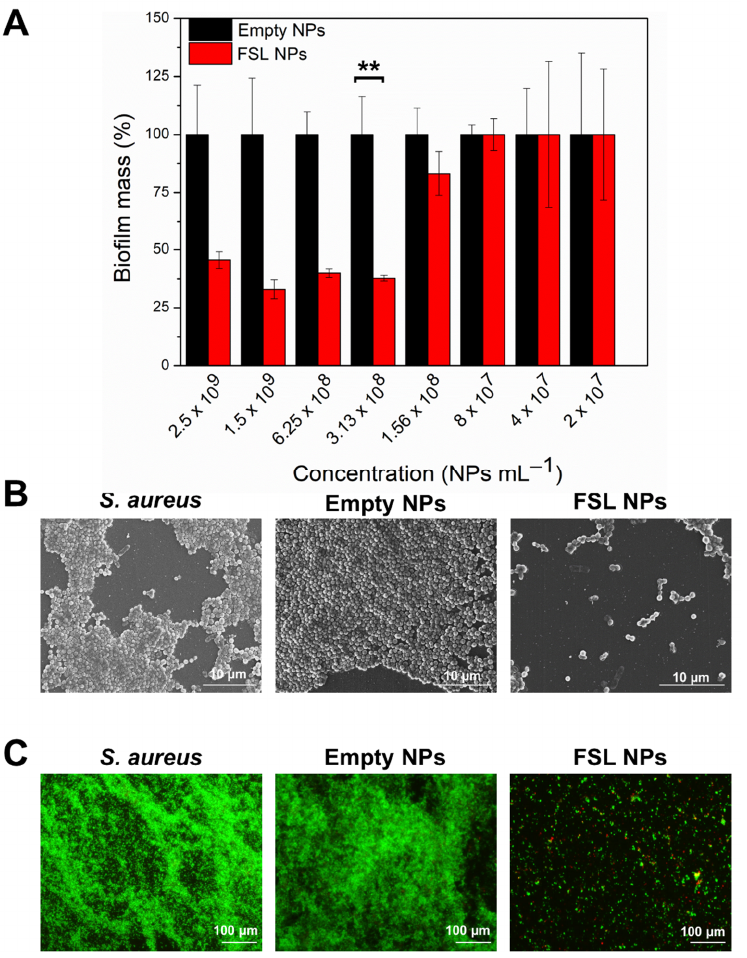
Figure 5. Elimination of S. aureus biofilm grown for 24 h. ( A ) Total biofilm quantification using crystal violet assay after treatment with increasing concentration of empty and FSL NPs. ( B ) SEM images of biofilm treated with 3.13 × 10 8 NPs mL −1 empty and FSL NPs. ( C ) LIVE/DEAD BacLight kit microscopic visualization of biofilm treated with 3.13 × 10 8 NPs mL −1 empty and FSL NPs. The green and red fluorescence images are overlaid. The dead bacteria are stained in red and live bacteria are stained in green. Stars represent the statistical differences between the biofilm reduction potential of FSL NPs at the lowest concentration able to reduce the mature biofilm and empty NPs ( p < 0.001).